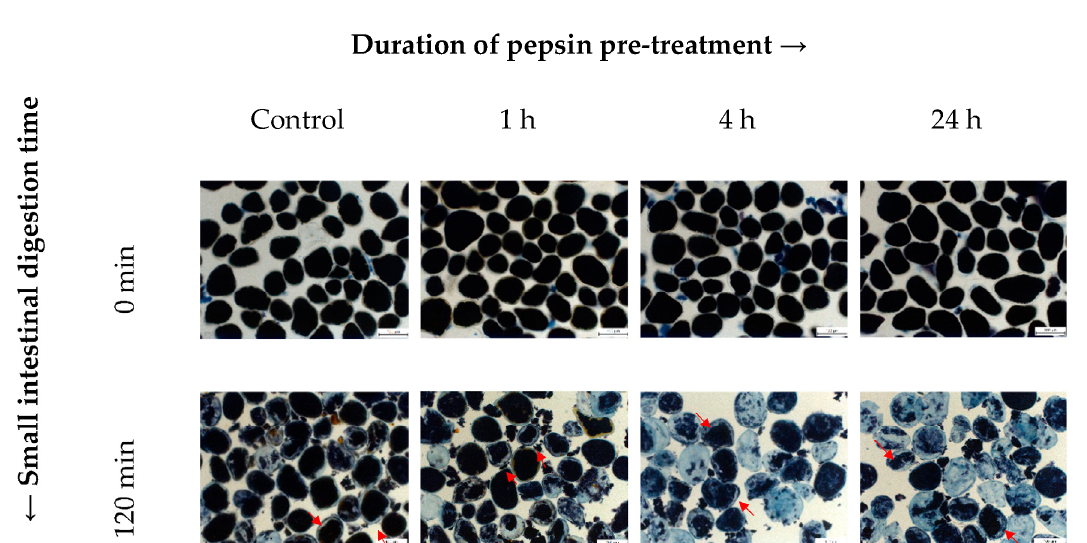
Figure 4. Representative brightfield light micrographs taken at 0 and 120 min of small intestinal digestion of control INCs and INCs pretreated with pepsin for 1, 4, and 24 h. The cells were stained with Lugol’s iodine reagent for detecting the presence of starch. Red arrows indicate empty “gap spaces”. Scale bar = 100 μ m.